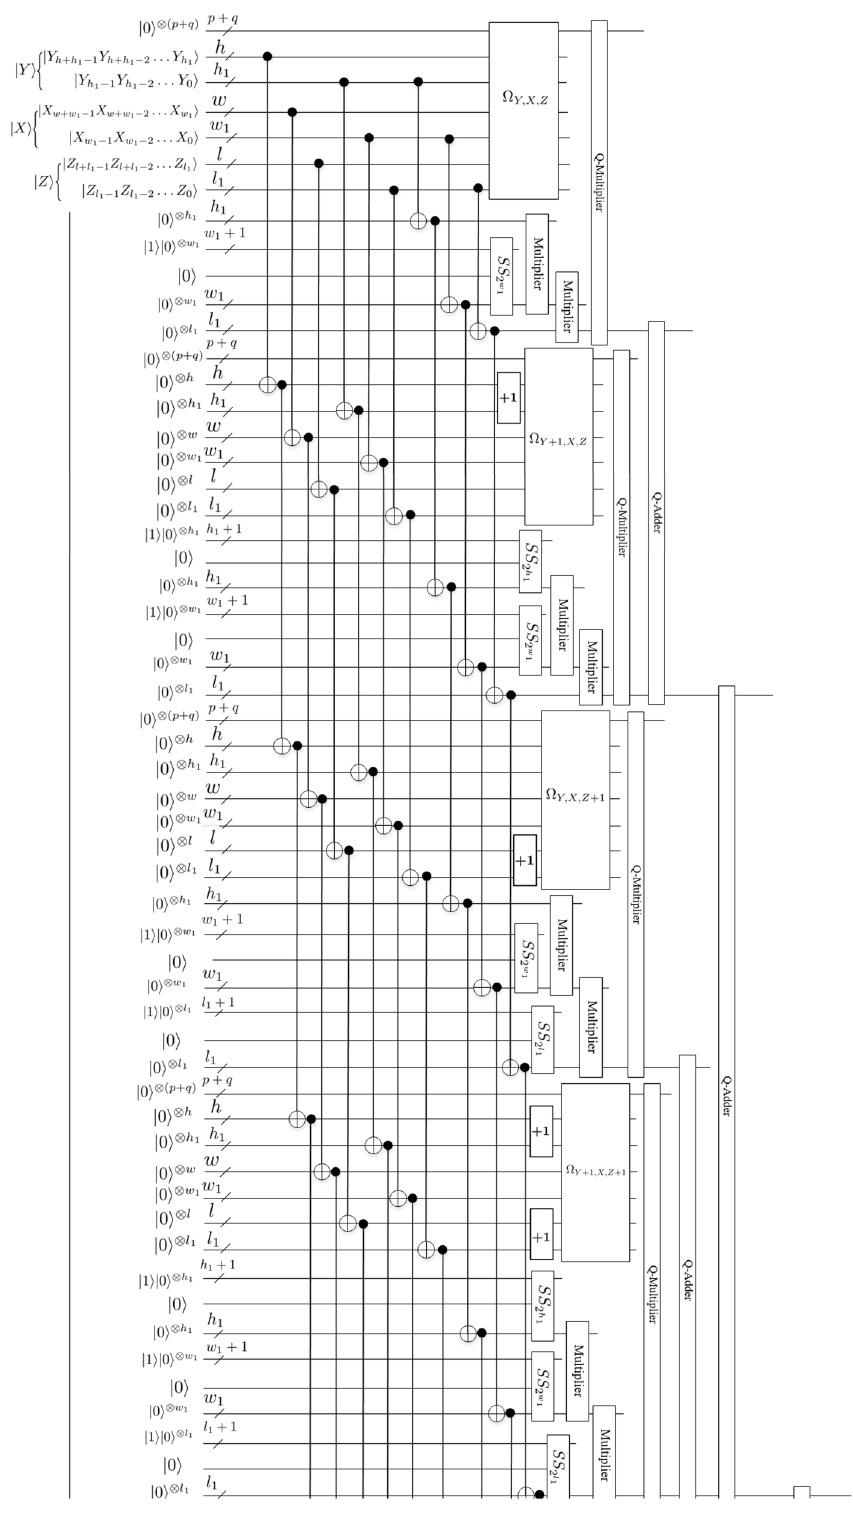
Figure 19. Scaling-down